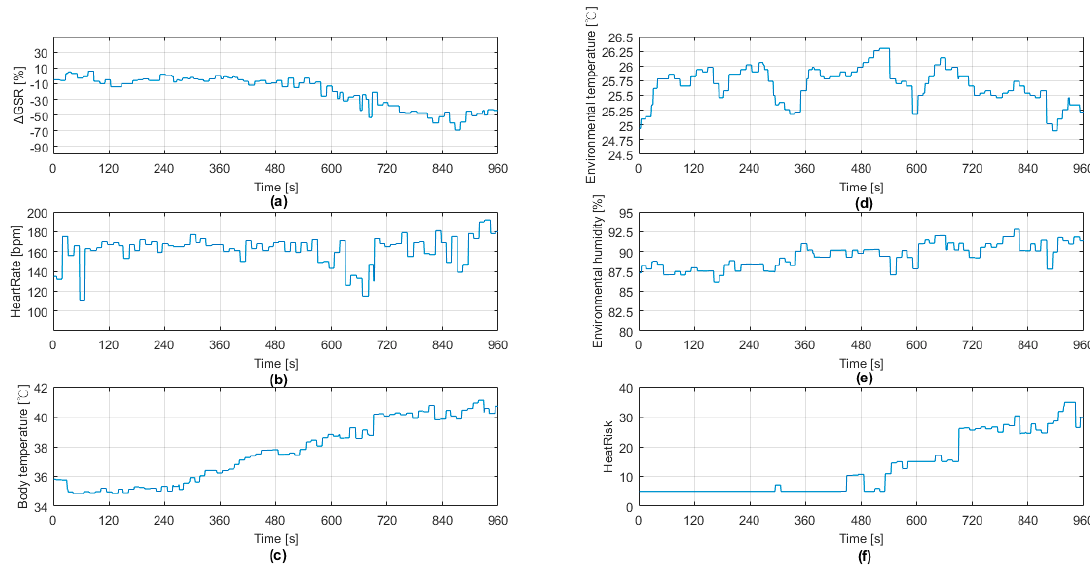
Figure 13. WHDD experiment results, with physiological information about ( a ) GSR, ( b ) heartbeat, ( c ) body temperature, ( d ) ambient temperature, ( e ) ambient humidity, and ( f ) the inferred risk of heat stroke provided by the evaluation system.